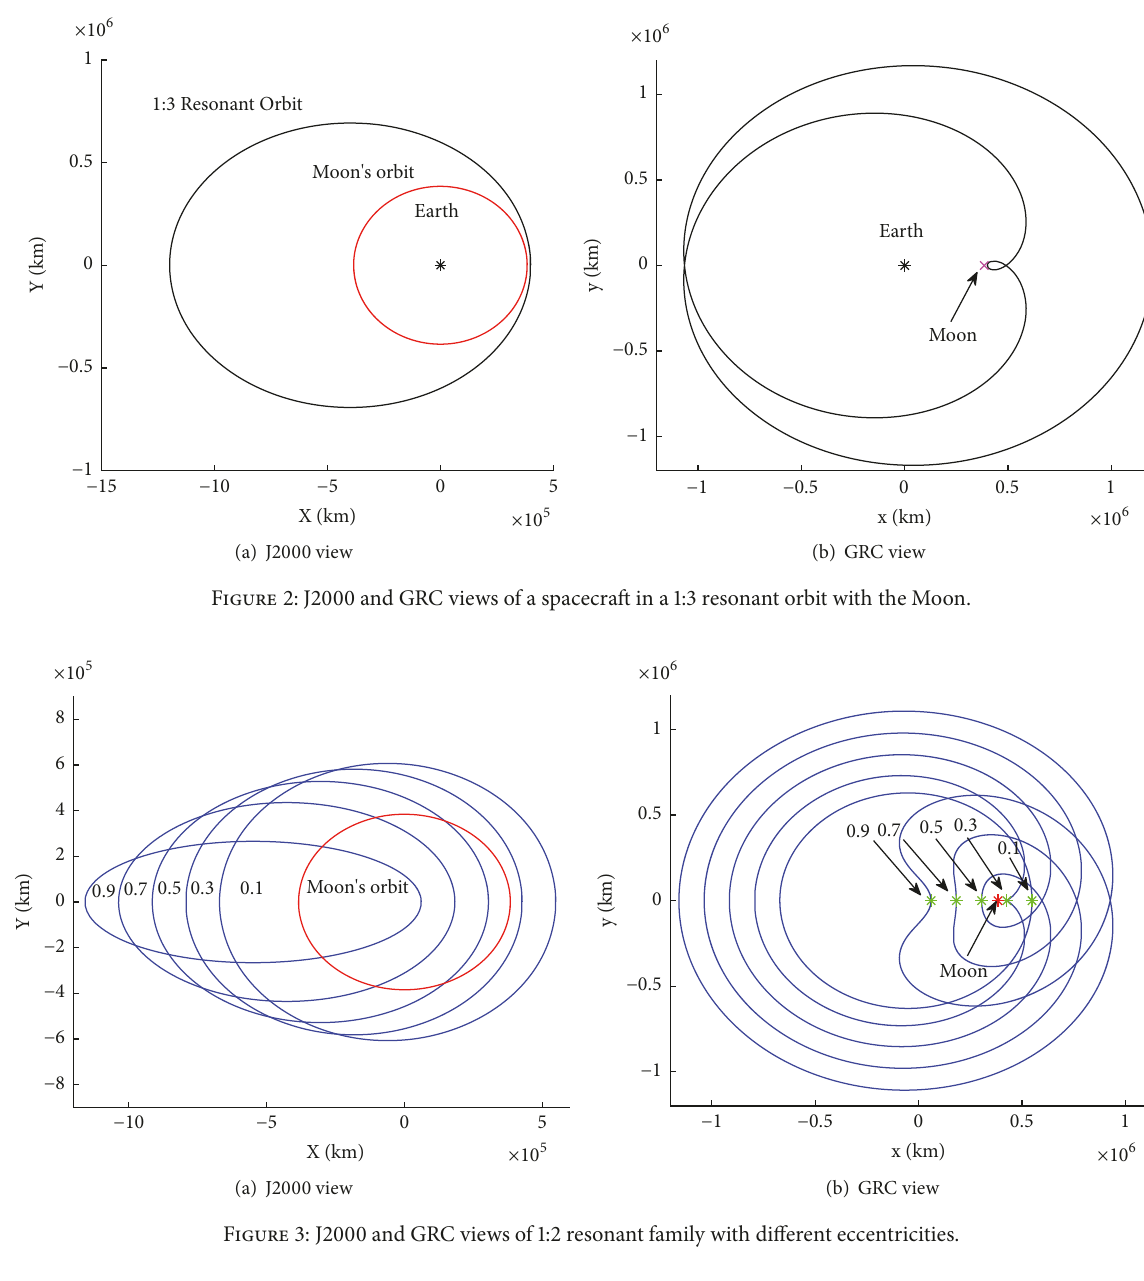
Figure 3. In Figure 3(a), the red trajectory is the Moon’s orbit, and the blue trajectories are the 1:2 resonant orbit family. In Figure 3(b), the red point denotes the Moon in the rotating frame, and the green points are the perigees of the resonant family in the rotating frame, which are also the closest points of the resonant family to the Moon.